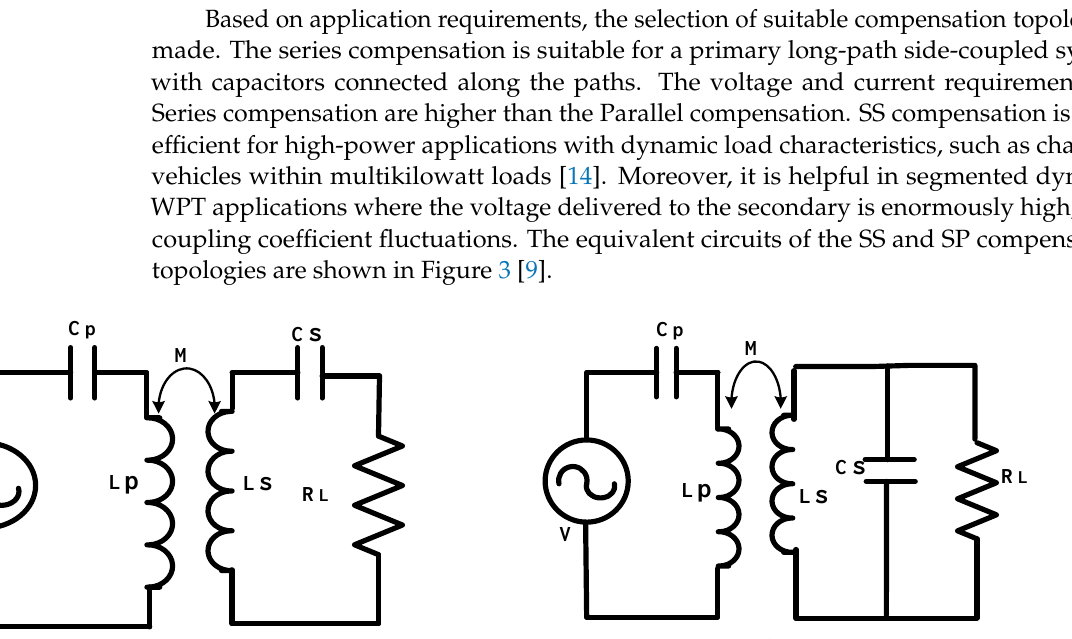
Figure 3. Equivalent circuit of Series compensation ( a ) Series – Series. ( b ) Series – Parallel topology. Whenever the receiver is inactive, the equivalent impedance at the fundamental resonant frequency is zero. A significant disadvantage of the SS topology is that only the parasitic impedance of the capacitor and the inductor controls the current. Another disadvantage of the SS compensation is that the load required for the power converter ratio does not depend on the load resonant frequency [11]. Since the SS compensation is independent of the coupling coefficient, interdependence could make control management more difficult. It results in a reduction in load performance [15]. It is also independent of √ L P ∗ L S , load, or resonance frequency, where M is the magnetic coupling coefficient = M / the mutual inductance, Lp is the primary inductance, and Ls is the secondary inductance. However, the SP architecture depends on the coupling factor and requires a higher primary capacity value for high electromagnetic interactions. The coupling coefficient’s mutual inductance (M) value is used to calculate the primary-side capacity of the SP topology. The secondary compensating capacitor (Cs) is estimated for the SS and SP topologies by substituting the secondary inductance Ls in the equation [16]. The primary input voltage controls the primary-side current magnitude in the SP topology. The SS and SP compensations operate at various resonance frequencies ω max = 1 √ for the selected L s . C s inductance and capacitance values. They roughly correspond to the optimum efficiency conditions for all the basic compensation topologies. The coupling coefficient influences